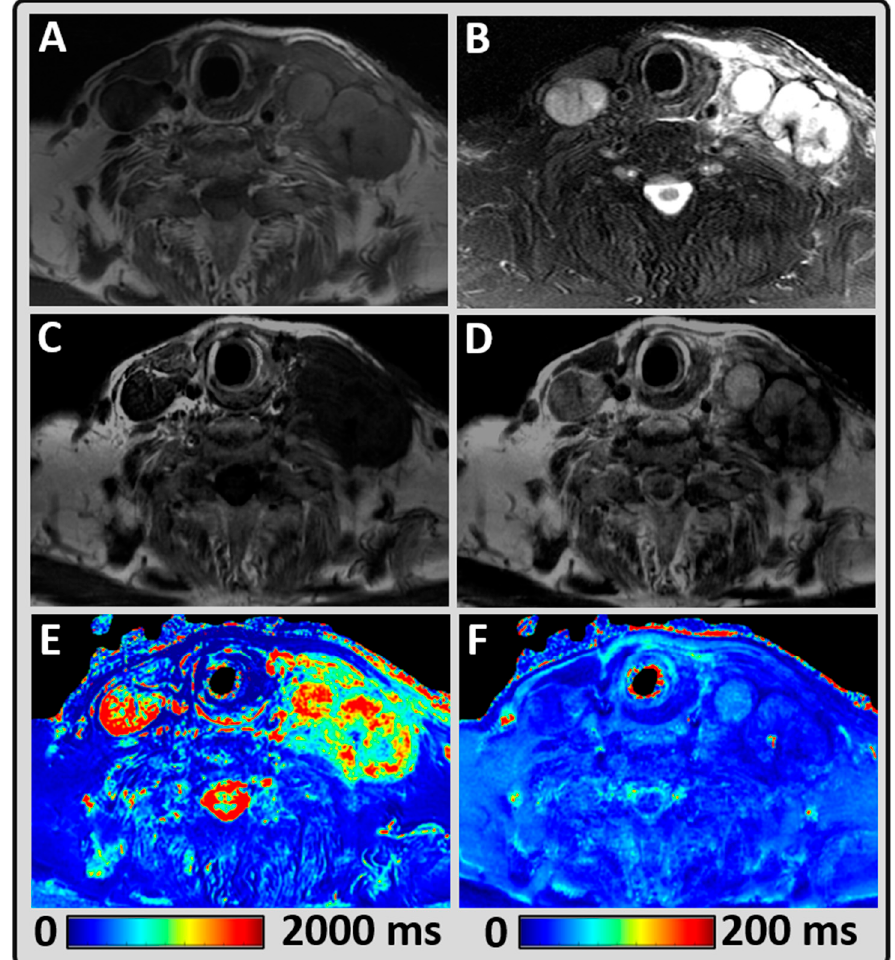
Figure 2. Representative MRI data from a 76-year-old male patient post-thyroidectomy with a bilateral metastatic supraclavicular lymph node. ( A , B ) Conventional qualitative T1- and T2-weighted (w) images depicting the metastatic tumors; ( C , D ) Synthetically generated T1w and T2w images using MAGiC; ( E , F ) MAGiC-generated quantitative T1 and T2 maps.